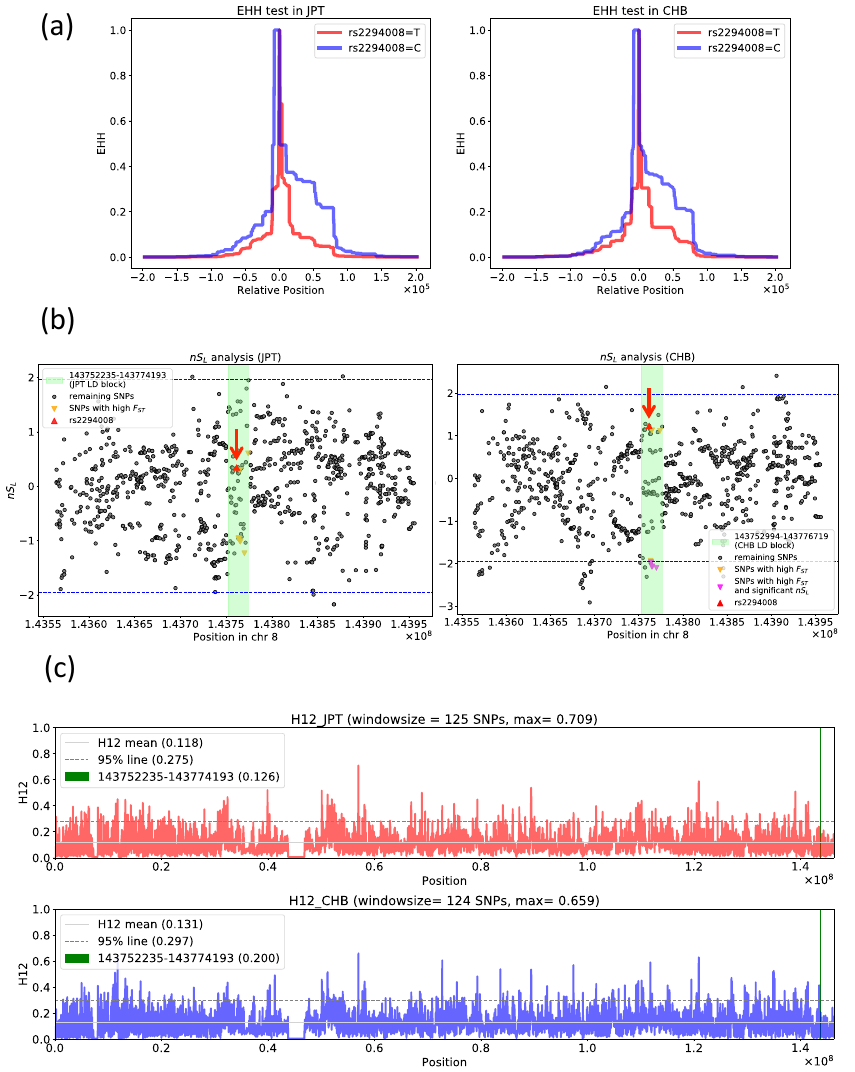
Figure 4. Neutrality tests (Extended haplotype homozygosity (EHH), number of segregating sites by length ( nS L ) and haplotype homozygosity (H12)). ( a ) EHH of the region surrounding rs2294008 in JPT (left) and CHB (right). ( b ) nS L of the region surrounding rs2294008 in JPT (left) and CHB (right). There was no limitation on the maximum size of the window. Each nS L value at rs2294008 in CHB and JPT is indicated by a red triangle, while the top ten highly di ff erentiated SNPs in CHB are indicated by inverted magenta triangles and the corresponding values in JPT are indicated by orange inverted triangles. The light green belt indicates the LD block region containing rs2294008 (JPT: 143,752,235-143,774,193, CHB: 143,752,994-143,776,719). Blue dashed lines represent 95% confidence intervals. ( c ) Sliding window analysis of H12 surrounding rs2294008 in JPT (upper) and CHB (lower). Light gray solid lines represent the H12 mean values within each population. The gray dashed lines represent the lower 95% line of H12 within each population. The light green line represents the JPT LD block region (143,752,235-143,774,193) used in this analysis. Values in parentheses in labels represent each H12